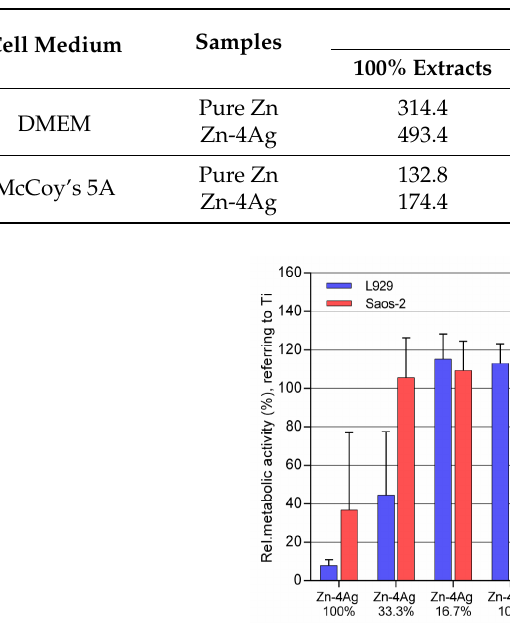
Table 3. The mean Zn ion concentration in pure Zn and Zn-4Ag alloy extracts.